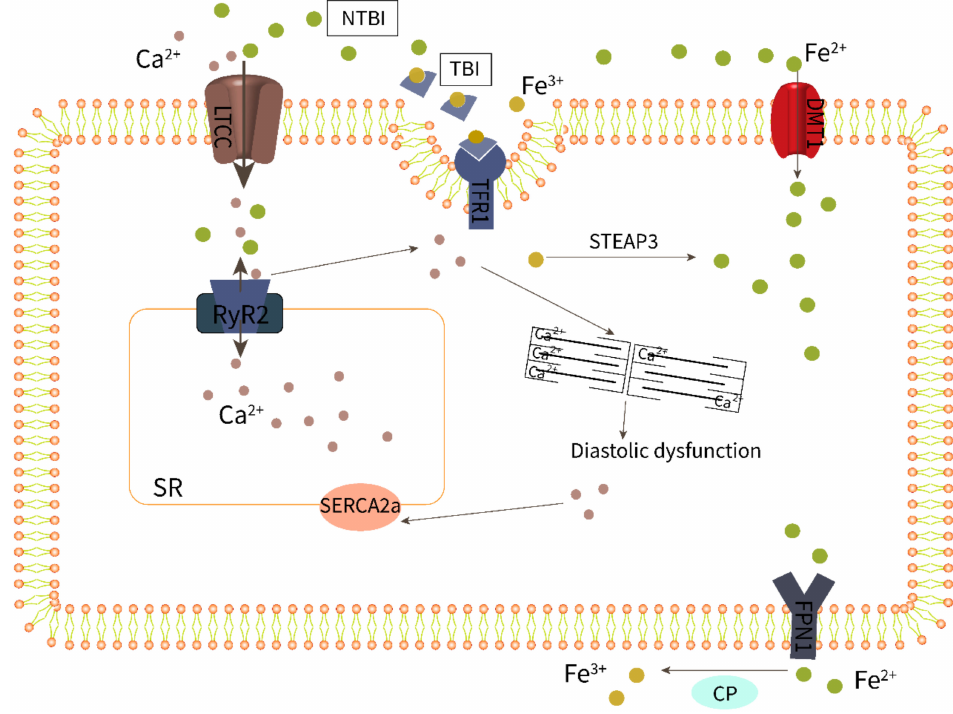
Figure 2. Iron overload impairs excitation–contraction coupling of